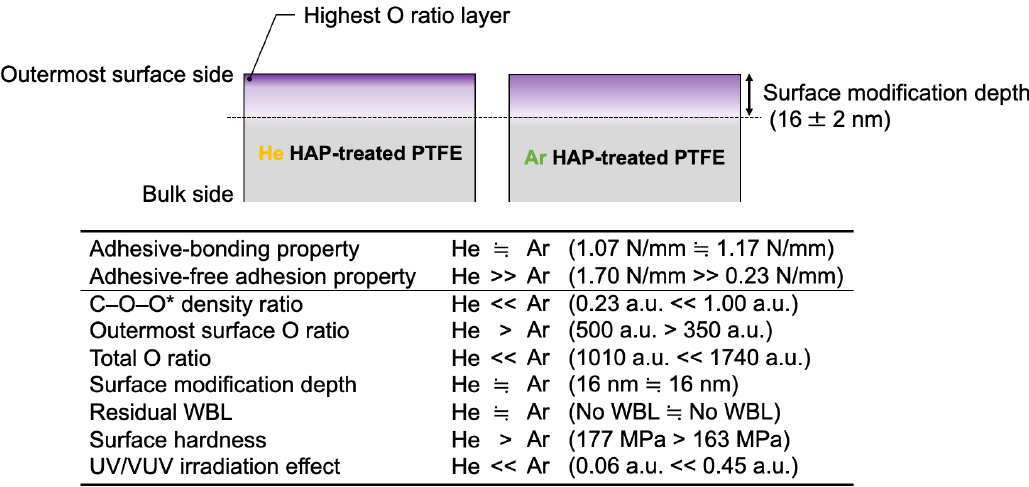
Figure 11. Schematic diagram of He- and Ar-HAP-treated PTFE surfaces and the summarized results.